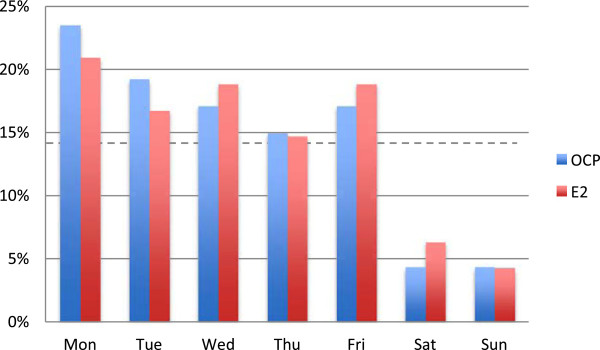
Distribution of oocyte retrievals across days of the week with OCP and E2 pretreatment, respectively. Note: Dashed horizontal line at 14.3% (1/7) shows proportion of retrievals per day expected to occur by pure chance.